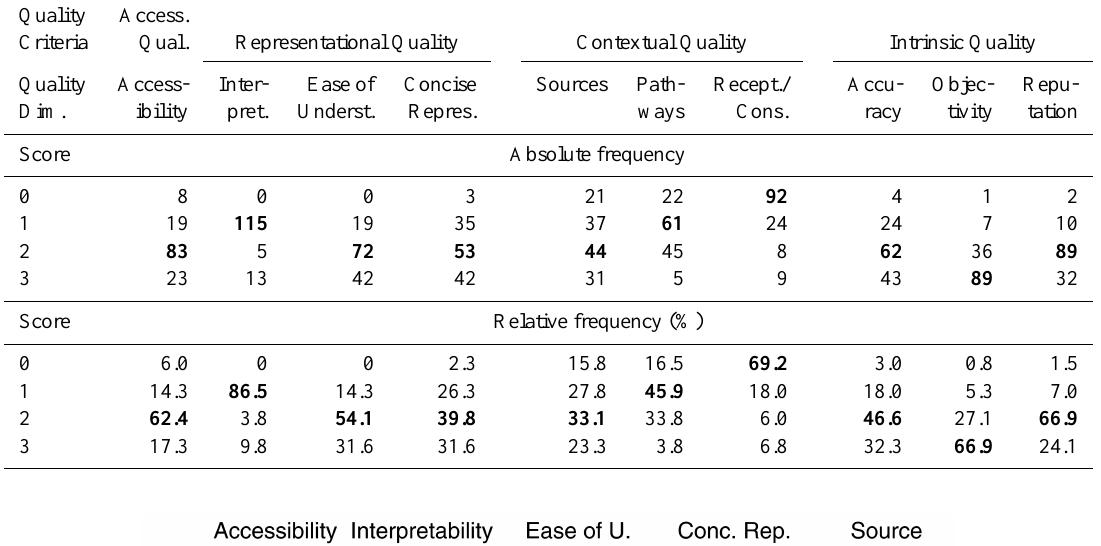
Table 3. Distribution of the scores per quality dimension, given in percentage of documents per score class. Bold numbers indicate the scores reached by the majority of documents.